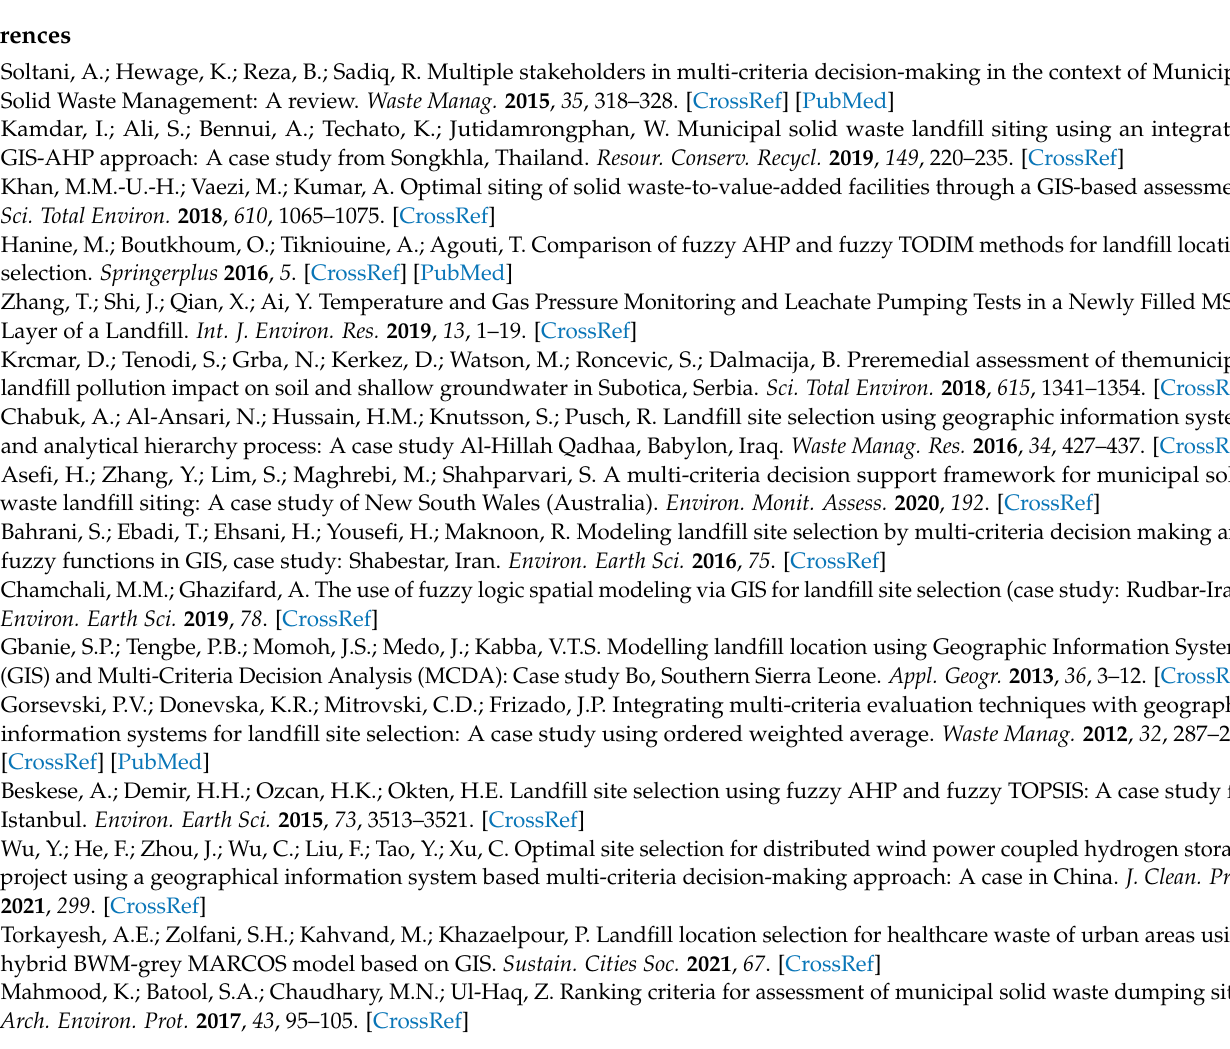
Figure A2. The left figure shows a comparison of the values of WASPAS for the candidate sites in each scenario. The right figure shows a comparison of the values of MOORA for the candidate sites in each scenario.